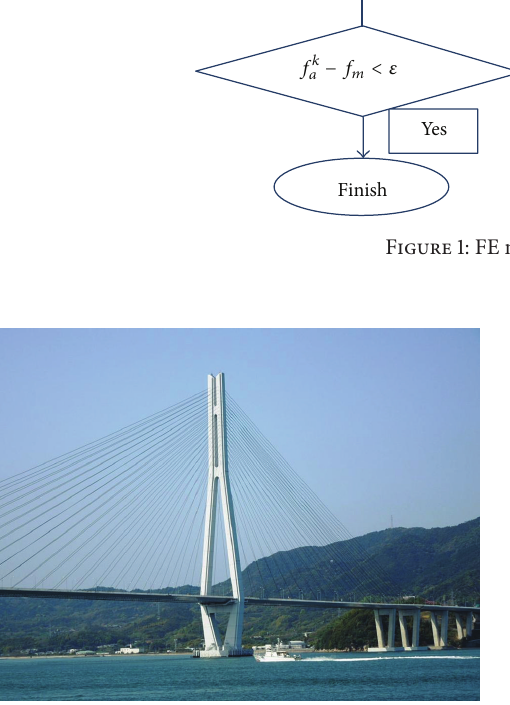
Figure 2: Tatara